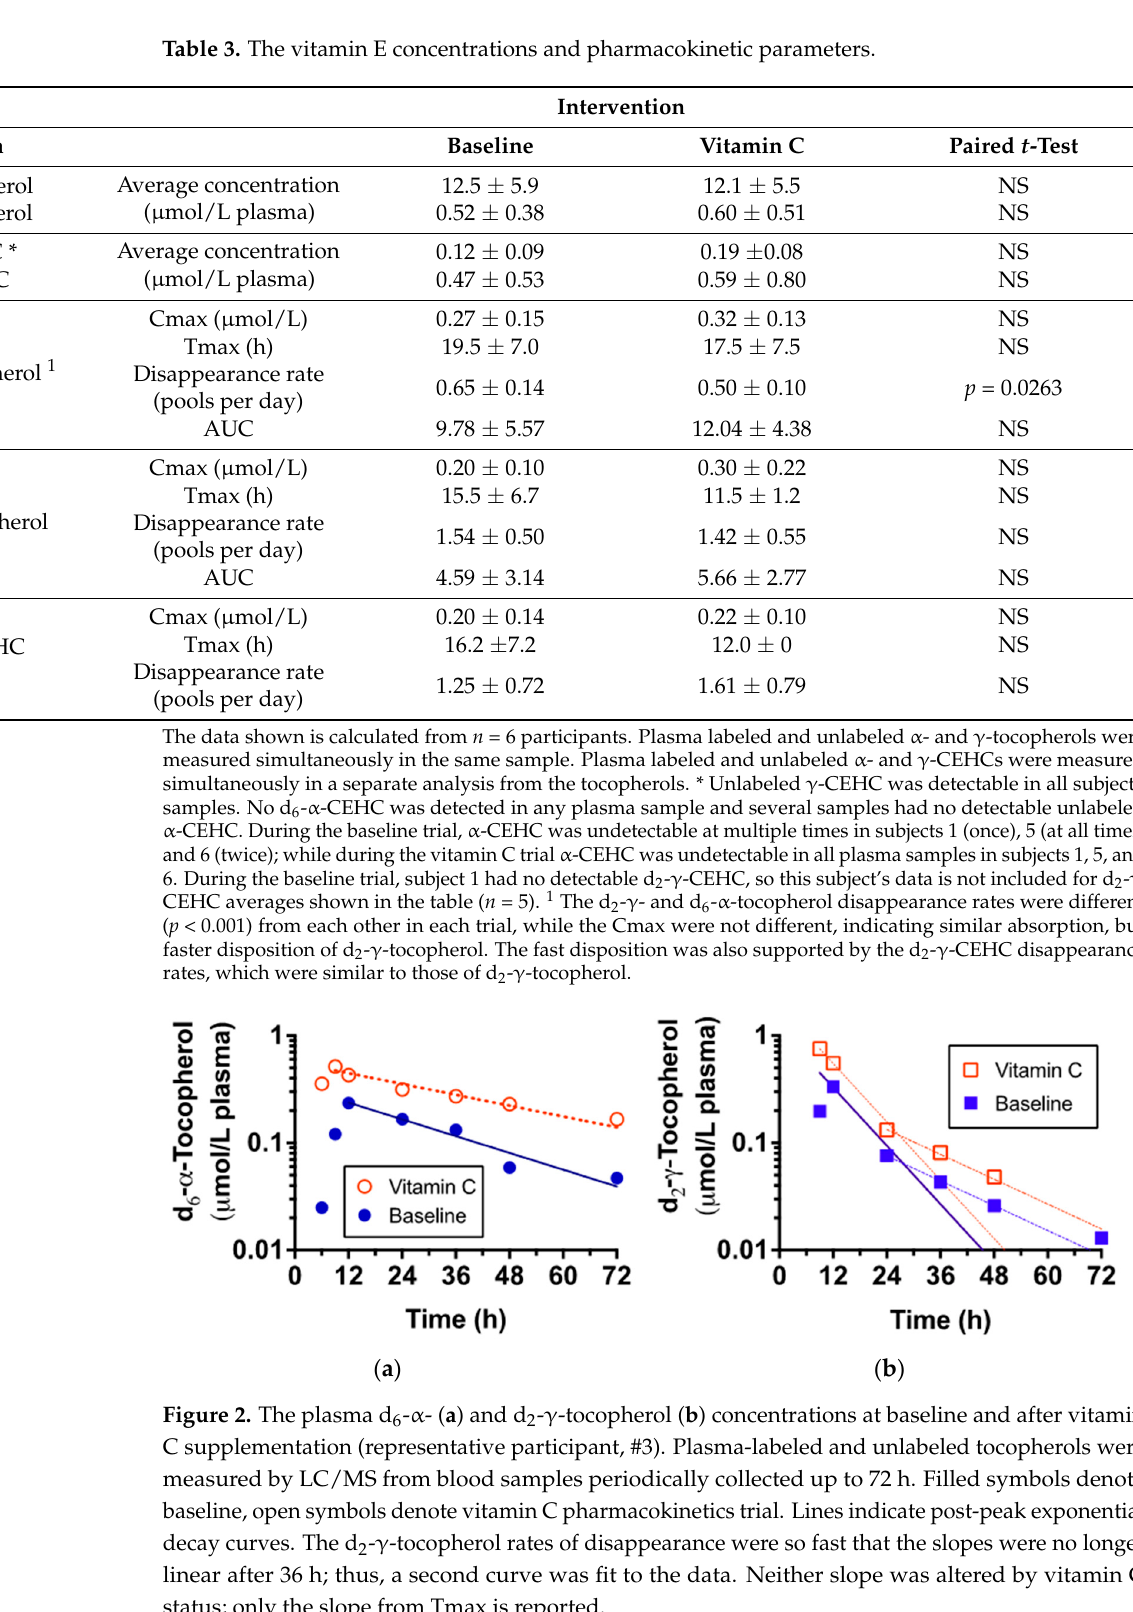
Table 3. The vitamin E concentrations and pharmacokinetic parameters.